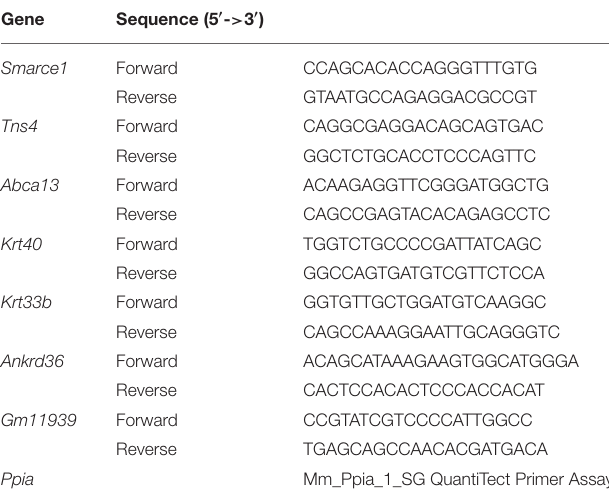
TABLE 1 | Primers used for RT-qPCR